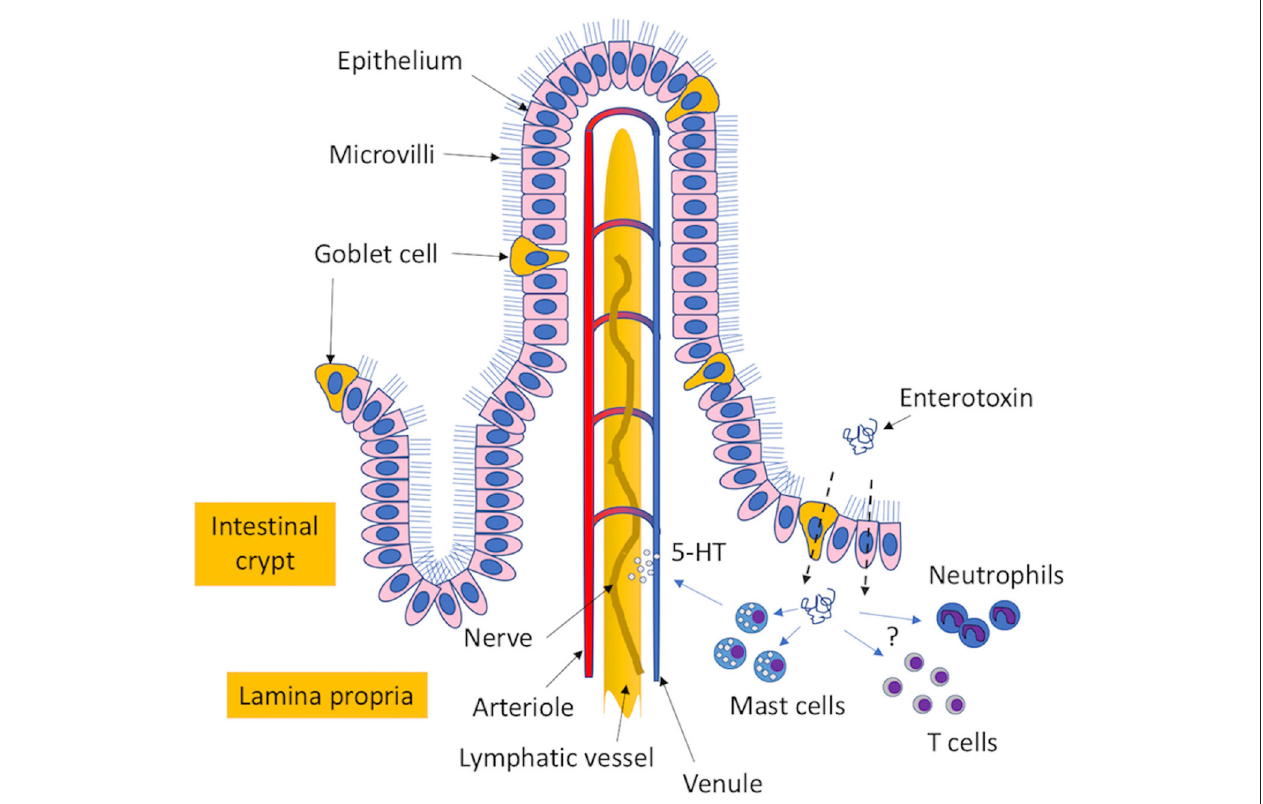
FIGURE 2 | Proposed mechanism of enterotoxin-induced emesis. The enterotoxins transit through mucus-expelling goblet cells and epithelial cells in the intestinal epithelium to reach the lamina propria. Here, the enterotoxins can interact with mast cells to induce the release of 5-hydroxytryptamine (5-HT/serotonin precursor), which interacts with the vagus nerve to cause an emetic response. Additional cellular targets that may have possible roles in the induction of enterotoxigenic disease include different types of T cells and